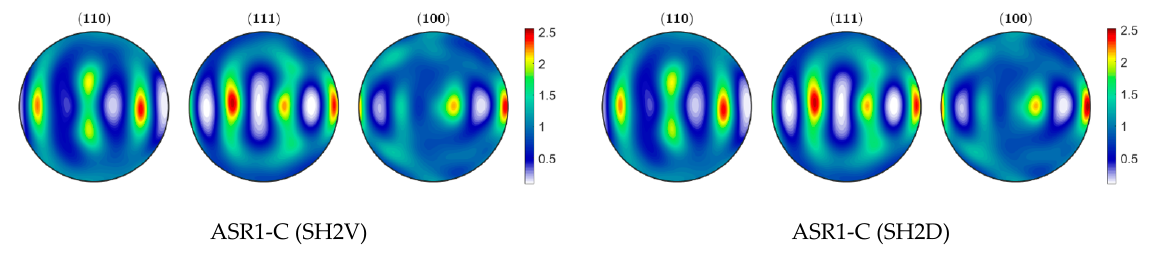
Figure A10. Pole figures for the first pass with a 30% thickness reduction per pass.